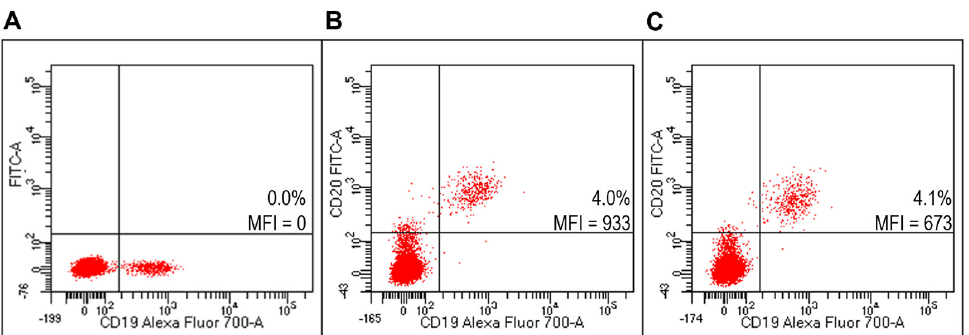
Figure 8. Evaluation of targeted lipoplexes on Raji cell line. Representative FACS profiles indicating the percentages of Fab(CD20)-FITC+ among Raji cells after staining with unlabeled and untargeted lipoplex ( A ), FITC-Ritux Fab ( B ) or targeted lipoplex ( C ).